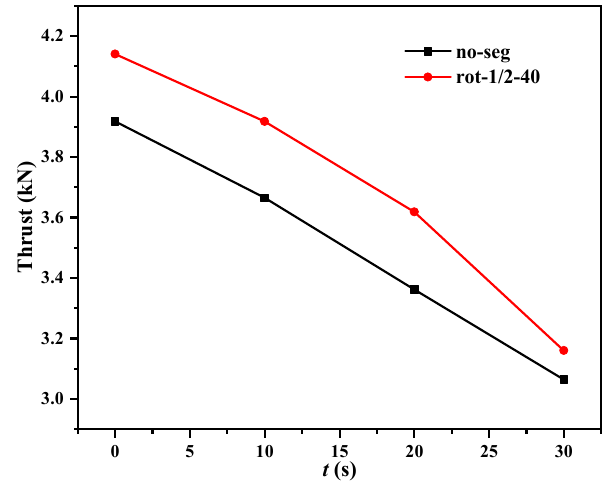
Figure 33. Thrust history in cases no-seg and rot-1/2-40.